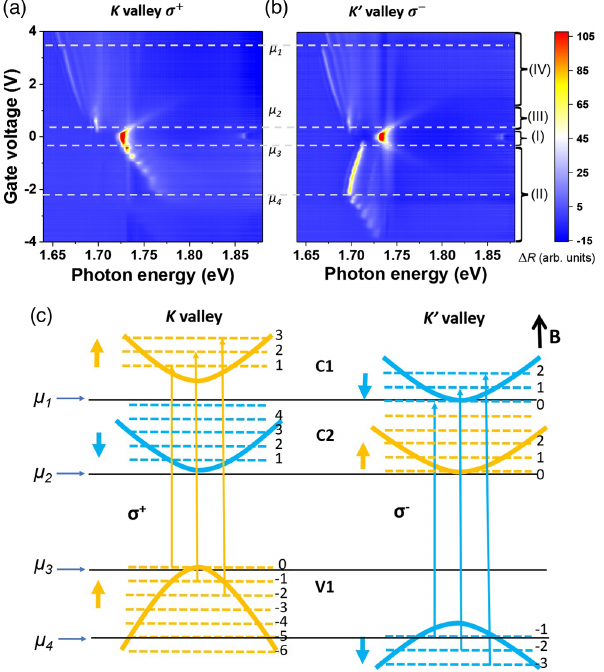
FIG. 2. Helicity-resolved optical magnetoreflectance spectra. (a),(b) Color plots of the helicity-resolved optical reflectance spectra for K and K 0 valleys, respectively, as a function of the top- gate voltage with the application of the out-of-plane magnetic field of 25 T. (c) The magnetic field lifts the degeneracy of the K and K 0 valley, and LLs form in the conduction and valence band. The arrows indicate the allowed inter-LL transitions in the K and K 0 valley. Fermi energies of μ 1 , μ 2 , μ 3 , and μ 4 correspond to different doping levels controlled by the top-gate